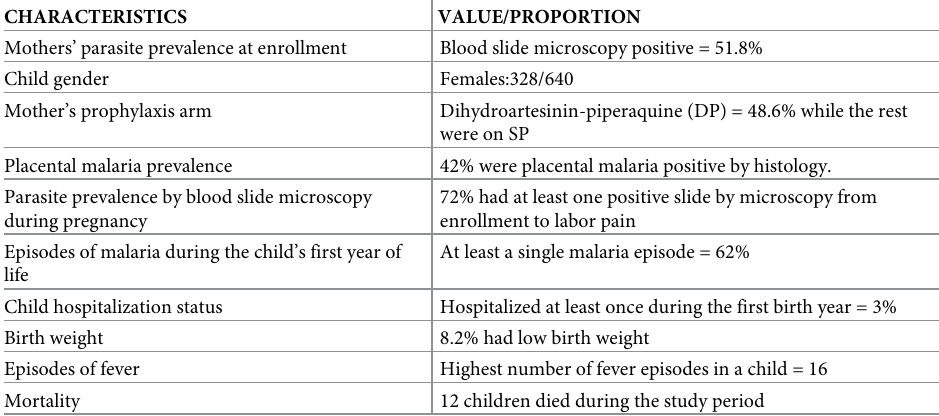
Table 2. Summary of key characteristics of study participants.